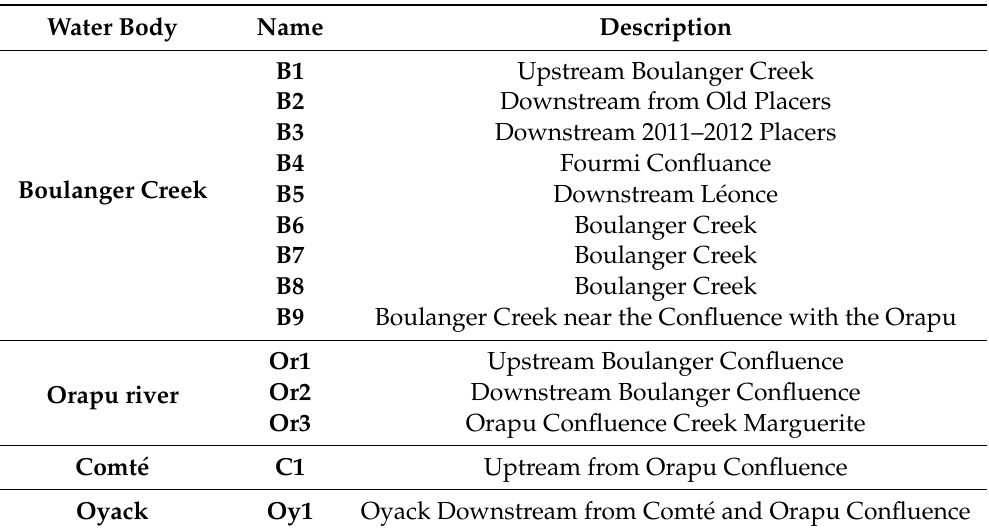
Table 1. Description of sampling